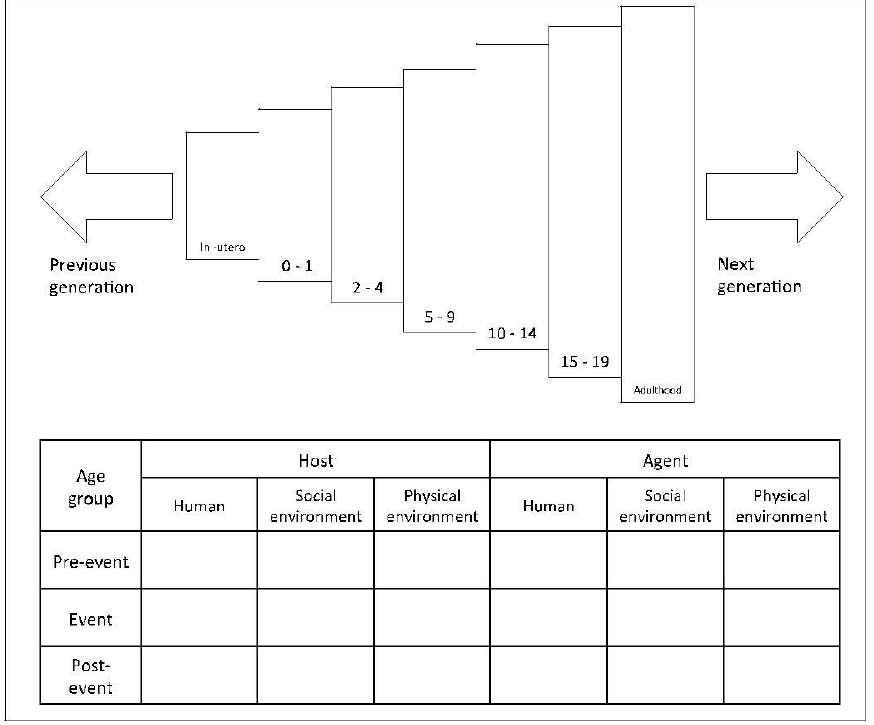
Figure 1. Local level child injury prevention assessment